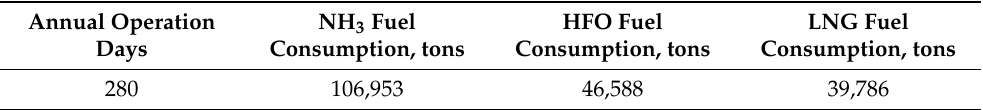
Figure 8. Fuel consumption for the engine loads for HFO, LNG, and NH 3 . Table 14. Annual fuel consumption for fuels.